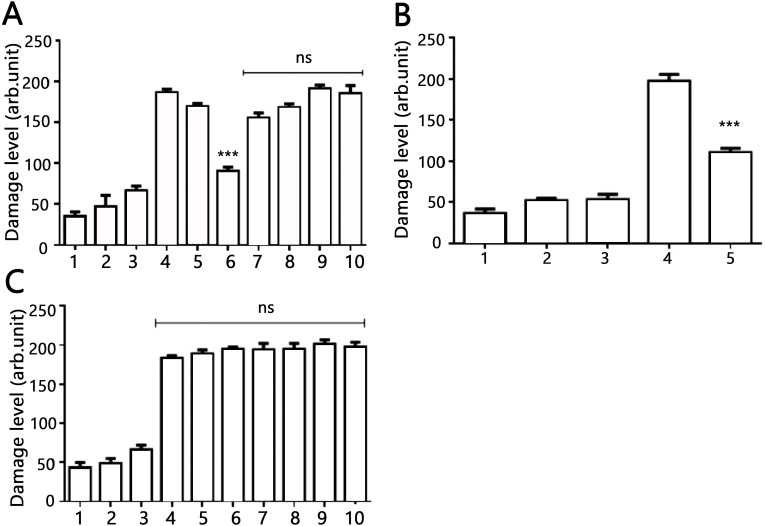
Effects of AV-153-Na and AV-154-Na against peroxynitrite caused DNA damage in HeLa cell line tested by comet assay.(A) AV-153-Na. 1, control (intact cells); 2, vehicle control (60 µM of NaOH); 3, peroxynitrite (200 µM); 4, incubation with the tested 1,4-DHP (100 nM, 45 min), 5, pre-incubation with 10 nm of 1,4-DHP (45 min) and treatment with peroxynitrite; 6, pre-incubation with 50 nm of 1,4-DHP (45 min) and treatment with peroxynitrite; 7, pre-incubation with 100 nm of 1,4-DHP (45 min) and treatment with peroxynitrite; 8, simultaneous treatment with 1,4-DHP (10 nm) and peroxynitrite; 9, simultaneous treatment with 1,4-DHP (50 nM) and peroxynitrite; 10, simultaneous treatment with 1,4-DHP (100 nM) and peroxynitrite; (B) AV-153-Na. 1, control (intact cells); 2, incubation with 50 nM of AV-153-Na for 3 h; 3, vehicle control (60 µM of NaOH; 3 h); 4, peroxynitrite (200 µM); 5, pre-incubation with 50 nm of AV-153-Na (3 h) and treatment with peroxynitrite; (C) AV-154-Na, all designations are as in A. ∗∗∗ - p < 0.001 versus peroxynitrite group, ns, not significant.